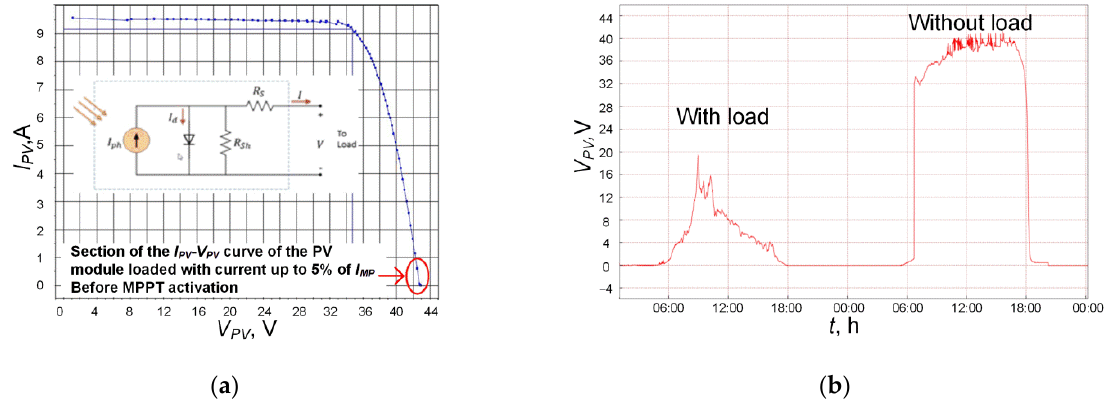
Figure 13. Characteristics of PV micro-power plant: ( a ) I PV vs. V PV of PV module; ( b ) V PV vs. t of PV module with and without load at a similar level of low illumination (covered by snow in both scenarios).